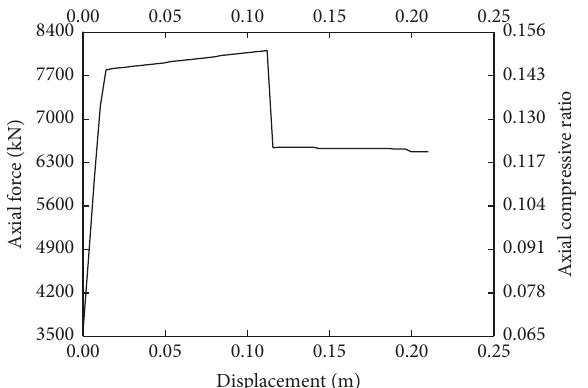
Figure 11: Axial force-deformation curve.